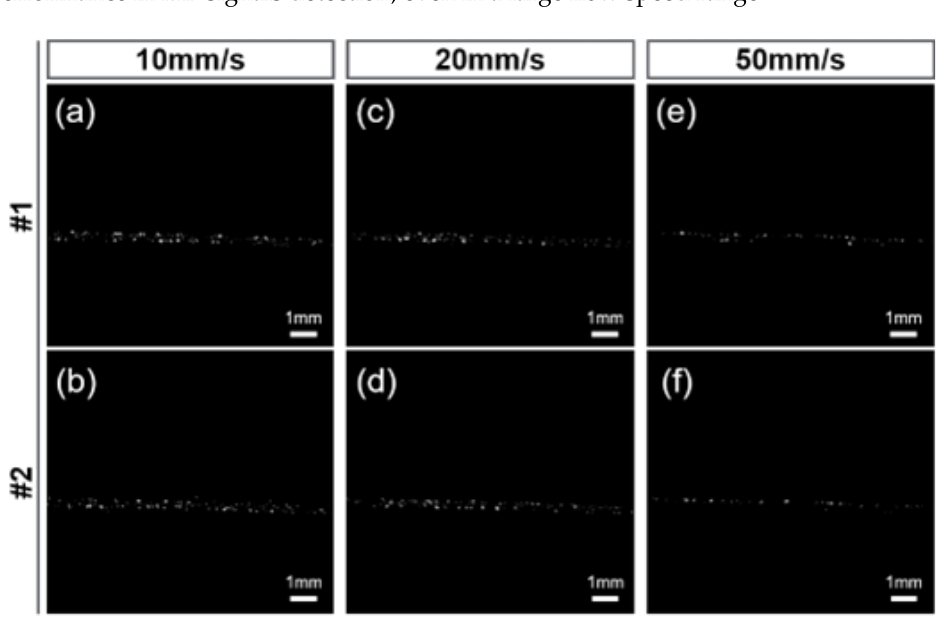
Figure 7. ( a , b ) The US image and the super-resolution image of the flow phantom. ( c , d ) The zoom- in views of the box regions in ( b ). ( e – g ) The reconstructed flow velocity map at 10 mm/s, 20 mm/s, 50 mm/s. To reveal the importance of the MB movement trajectories optimization step and im- age deconvolution algorithm for the ULM imaging technique, the comparison results of employing the two proposed methods are shown in Figure 8. Firstly, Figure 8a–d display the MB trajectories (Figure 8a–c) persistently tracked successfully for ten consecutive frames, and the optimized trace (Figure 8b–d) restricted by velocity, direction and accel- eration. The remarkable promotion of applying the trajectory optimization step after MB tracking is clearly illustrated in these examples. Without trajectory optimization, numer- ous inferior trajectories presented features such as excessively long distances or disor- ganized or reversed paths. Figure 8e–g further manifested the capability of the image de- convolution algorithm in flow velocity calculation. The calculated velocity results of the image deconvolution algorithm were shown in Figure 8f. From these contrasting results, we can see that the calculated mean flow speed is closer to the pre-defined value and less biased after performing the algorithm. With the use of the image deconvolution algorithm,